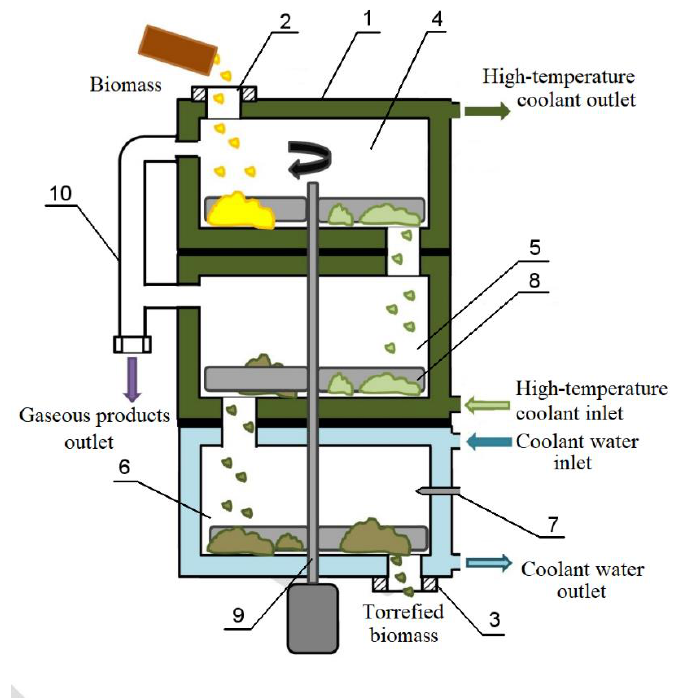
Figure 3. Scheme of a heart-type reactor for the torrefaction of sunflower husks in an environment of gaseous torrefaction products.